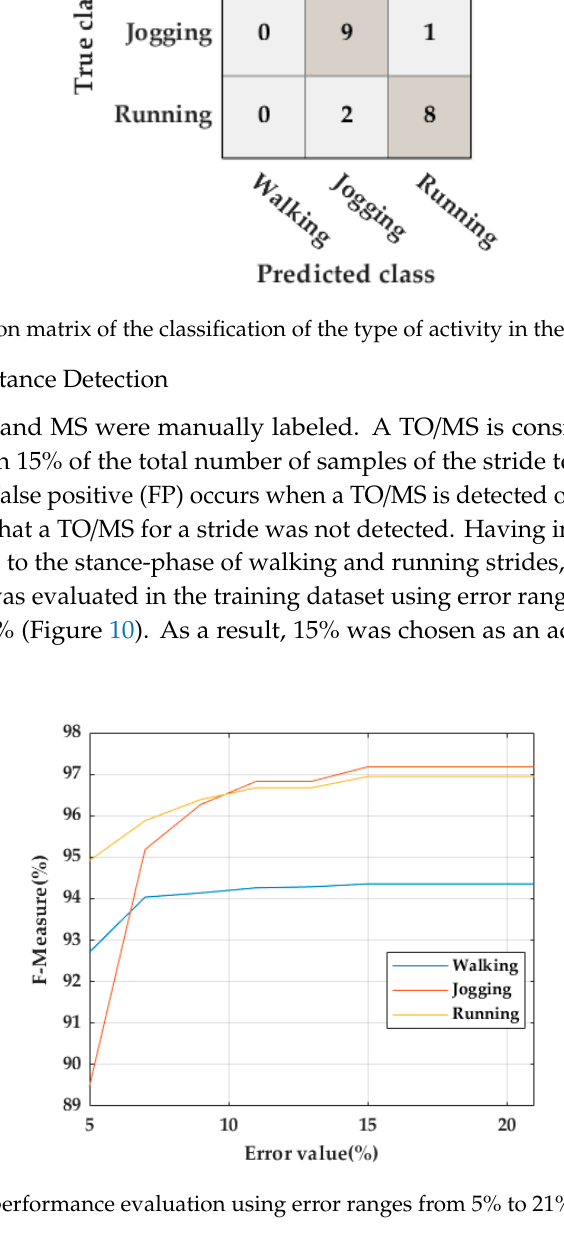
Figure 10. TO performance evaluation using error ranges from 5% to 21% in steps of 3%.